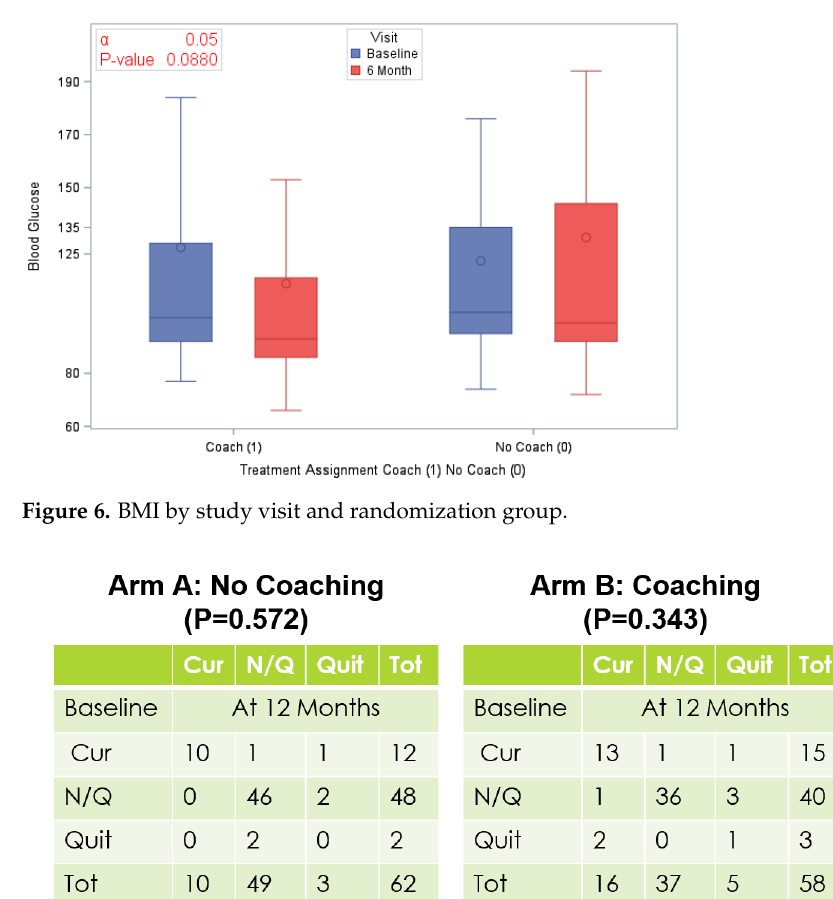
Figure 7. Baseline vs 12 months smoking status.